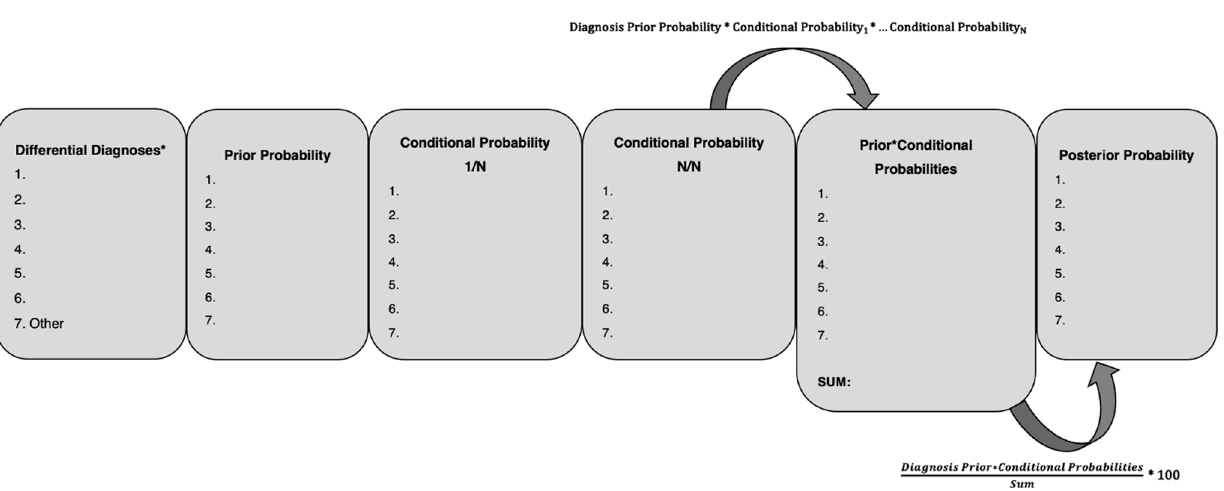
Table S1: Biochemical and hematologic values for an approximately 1-year-old ferret presenting for two days of lethargy and inappetence and one day history of diarrhea; Table S2: Individually esti- Table S2: Individually estimated prior probabilities for each of 7 differential diagnoses and conditional probabilities of diagnostic findings given a known diagnosis; Table S3: Individually